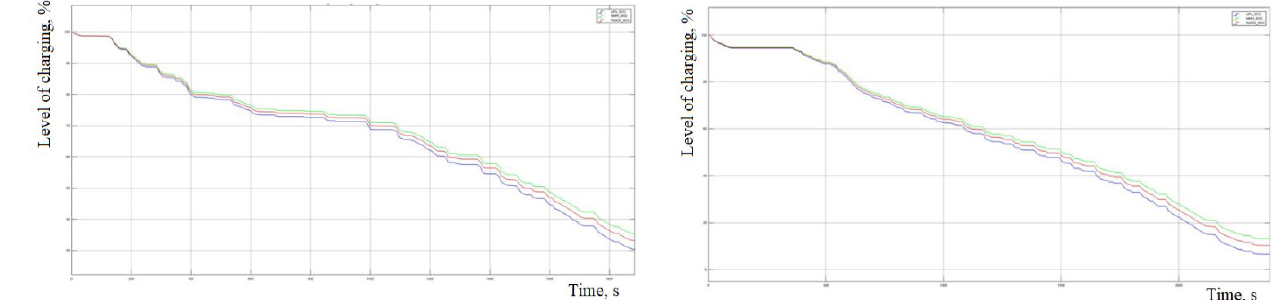
Fig. 8. Discharge levels of different accumulators of routes No. 5 and No. 2. Green – nickel-metal hydride, red – lead acids; blue –